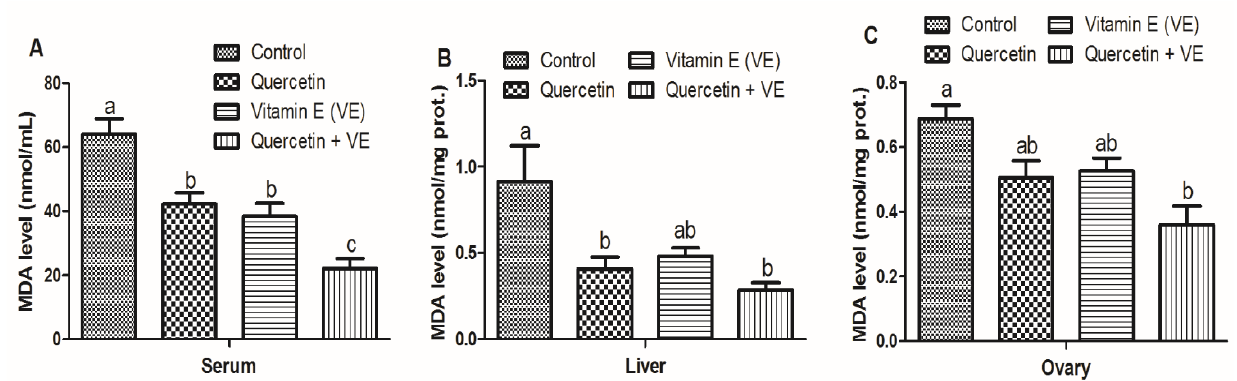
Figure 5. Effects of quercetin, vitamin E, and quercetin + vitamin E on the serum, liver, and ovary methane dicarboxylic aldehyde (MDA) level of aging breeder hens. Levels of methane dicarboxylic aldehyde (MDA) ( A – C ). The values are presented as the mean ± SD. Bars without the same letter differed significantly ( p < 0.05). prot: protein.